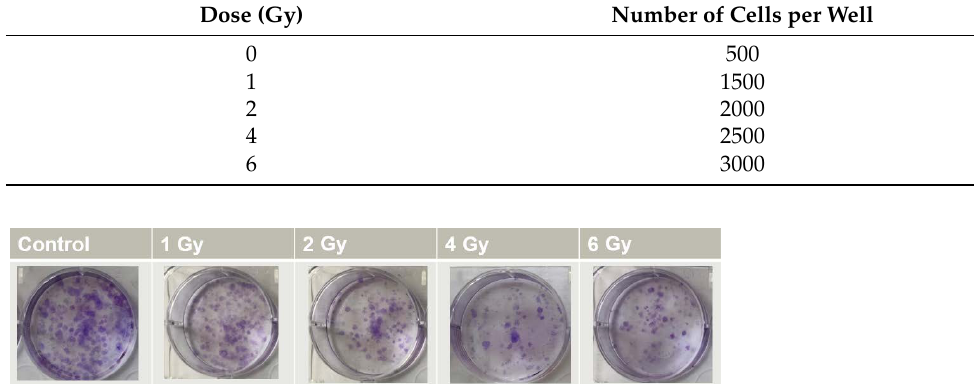
Table 1. Cell counts of DU145 and MM418-C1 cancer cells per well which were seeded in 6-well plates in order to perform a clonogenic assay.